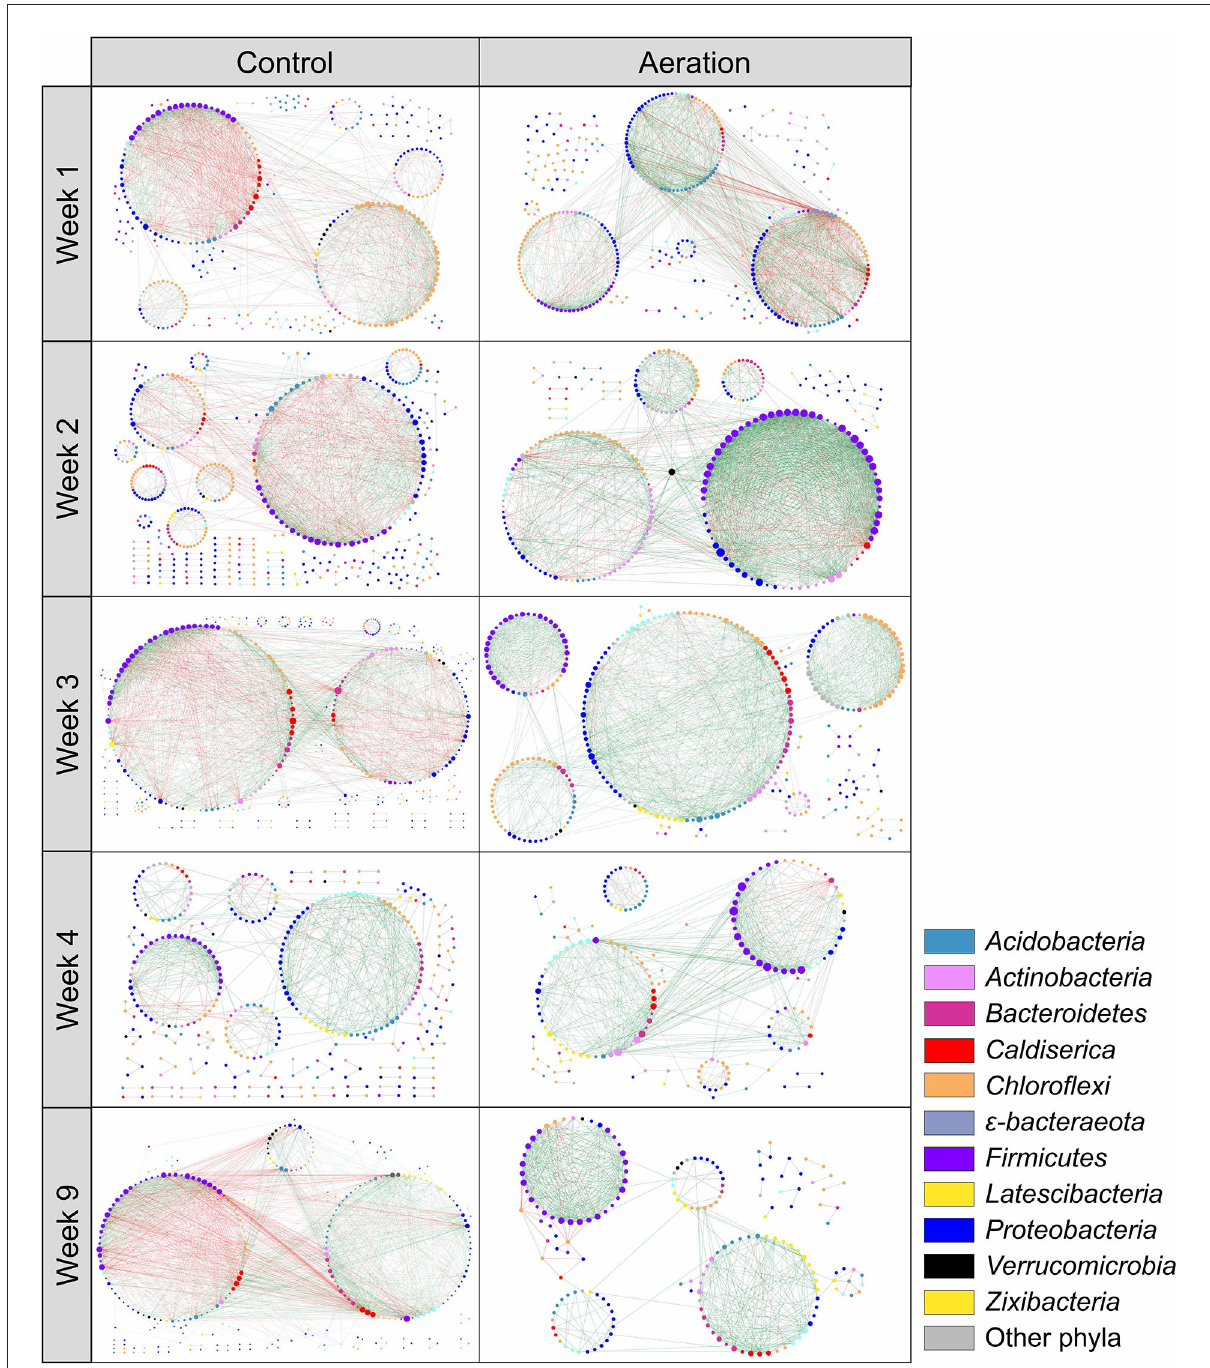
FIGURE2 Temporal pMENs showing significant abundance covariations of sediment microorganisms at five sampling times during the 9-week incubation under aeration. Each node represented an ASV in different modules. Major contributing phyla were colored. Node size was proportional to node degree. A link represented a significant Spearman’s Rho rank correlation between two nodes, green for positive and red for negative correlations.